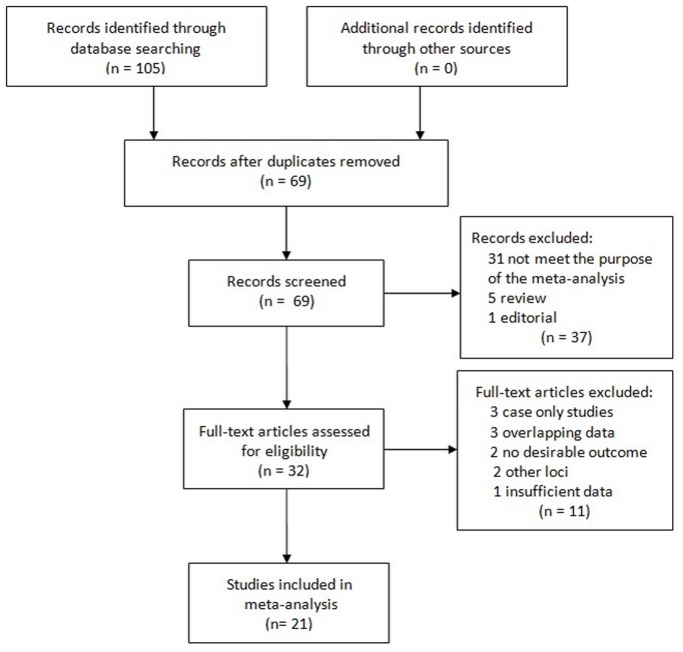
Study selection process.